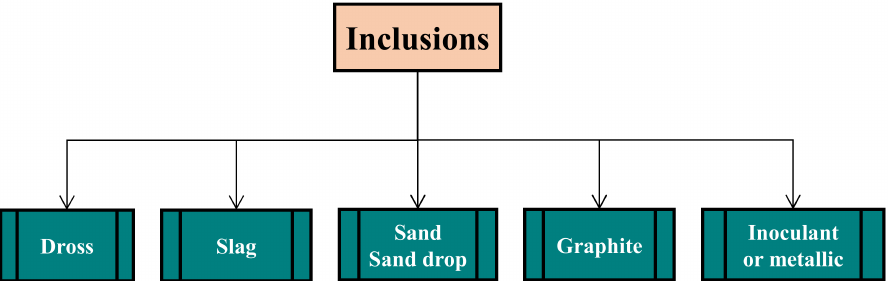
Figure 32. Classification of inclusions found in iron